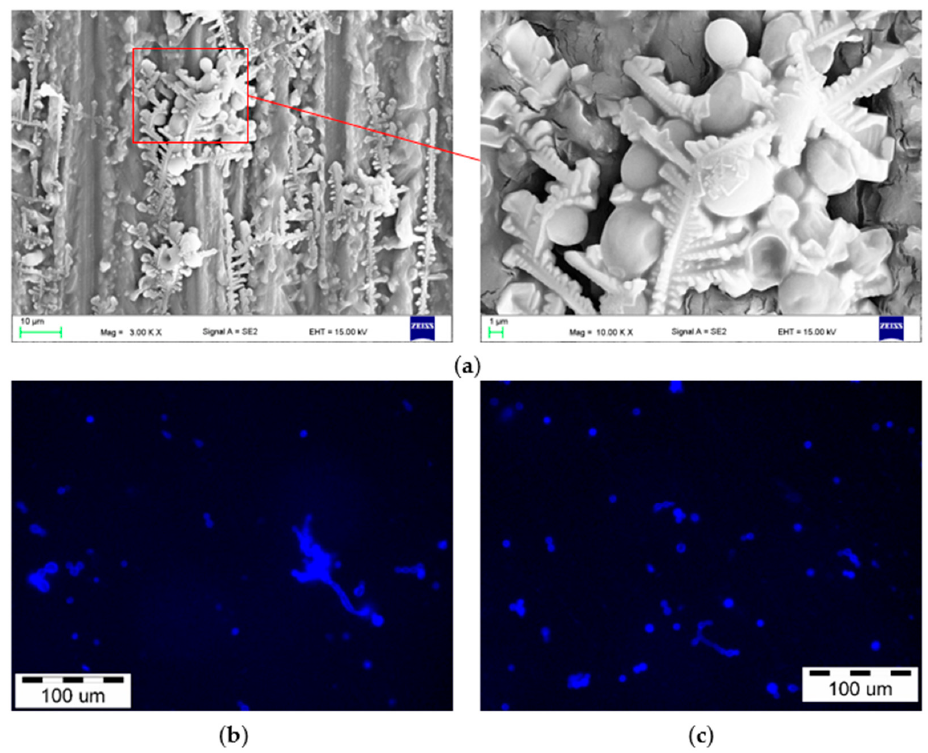
Figure 6. Representative microphotographs of the surface of the samples after 90 days of incubation in the C. albicans suspension obtained by SEM ( a ) and fluorescence microscopy ( b , c ).